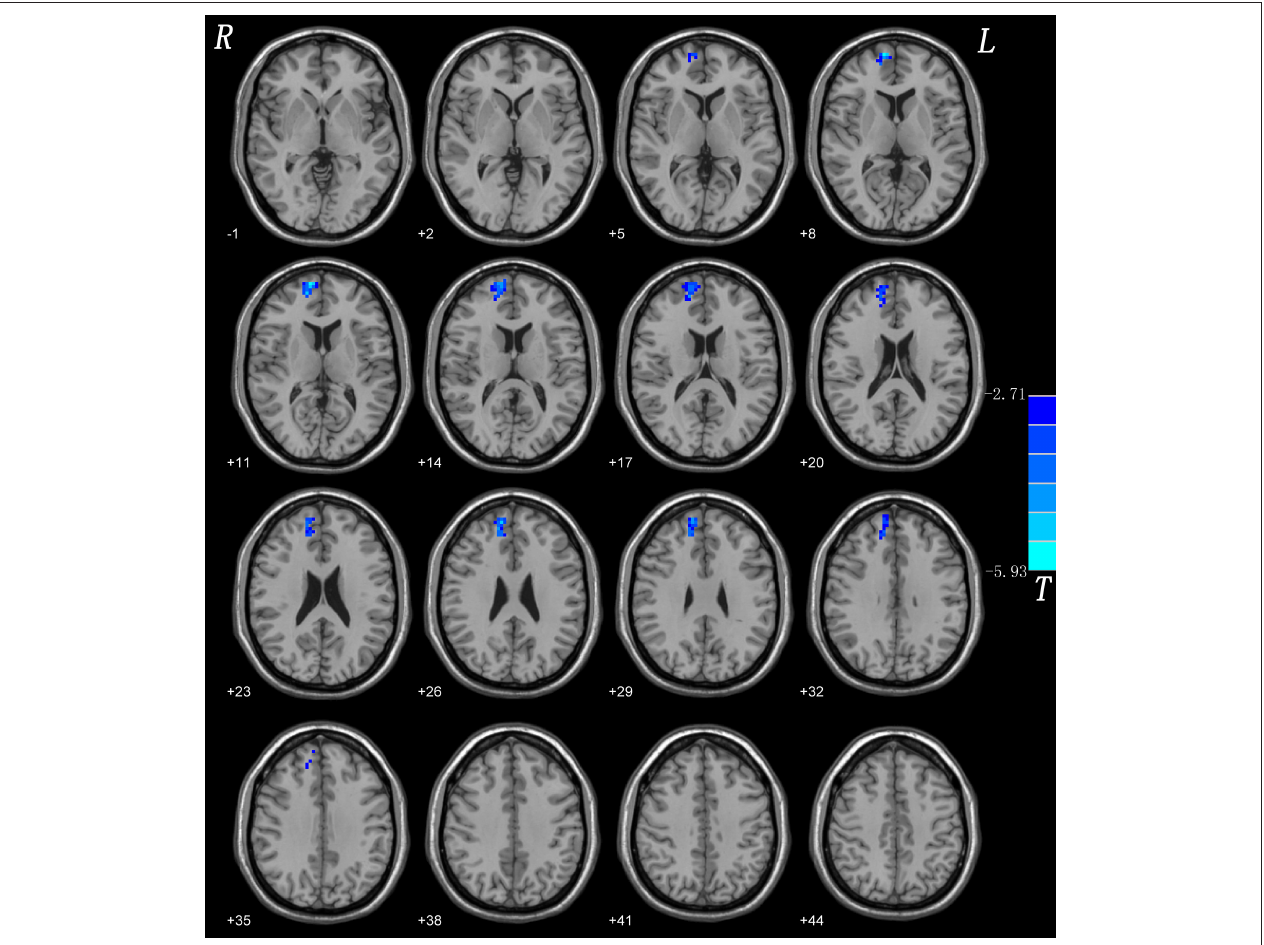
FIGURE 1 | NH differences between patients with CD and controls. Red and blue denote higher and lower NH respectively and the color bars represent the t values from two-sample t -test of the group analysis. NH, network homogeneity; CD, cervical dystonia.